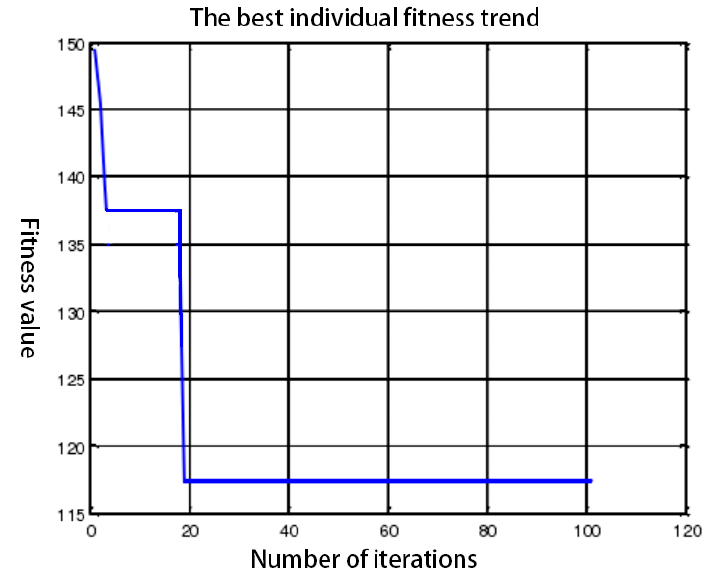
Figure 13. Fitness curve of the proposed improved GA algorithm for the Problem 1.